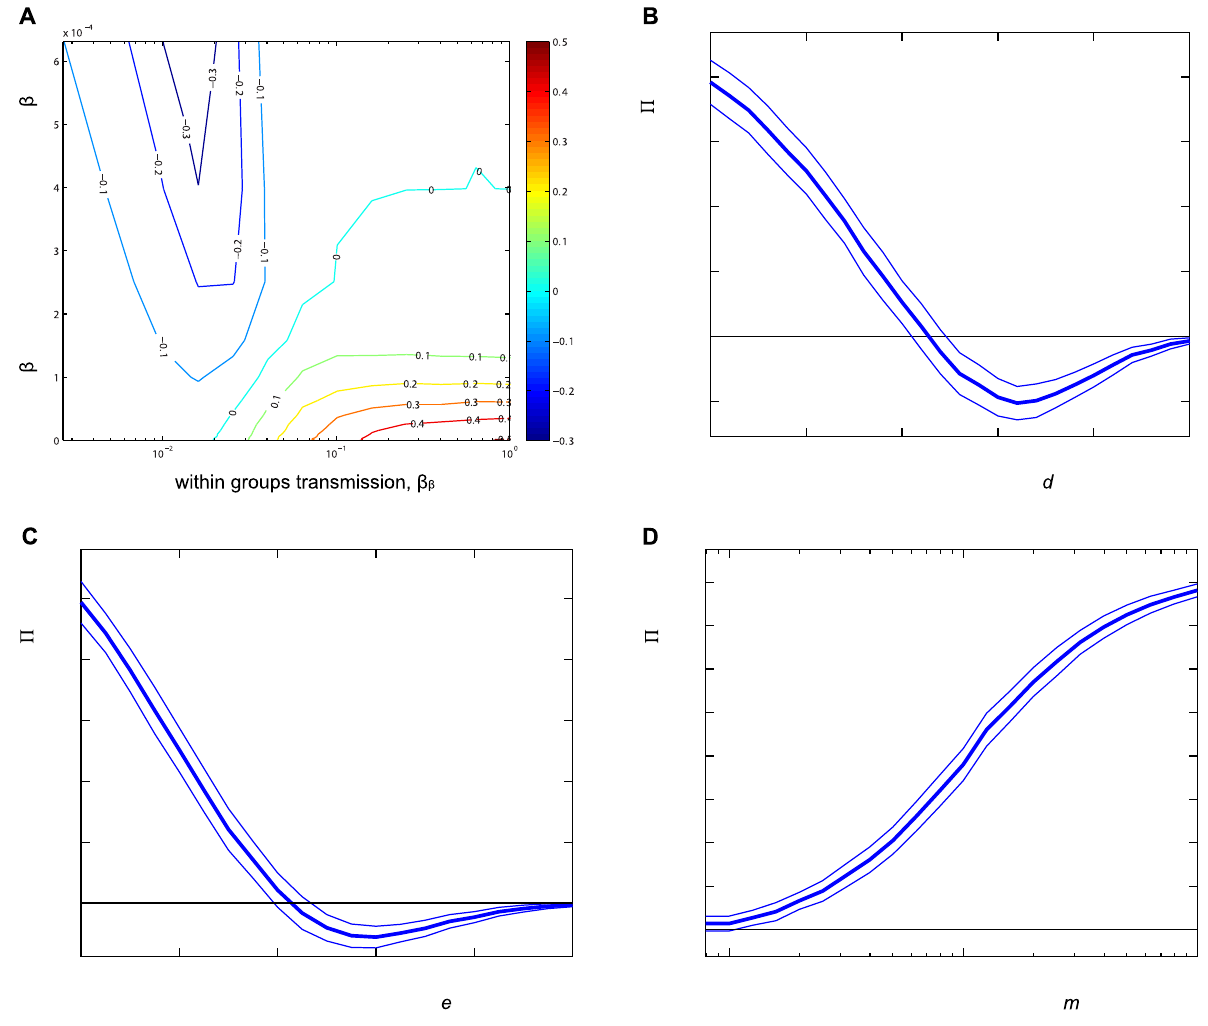
Figure 4. Sensitivity analysis of P in the stochastic model. The size of the perturbation effect, P sites , at time t ~ 20 starting near the disease free equilibrium for (A) Between and within-groups infection rates b b and b w (log scale). (B) Natural mortality rate d . (C) Disease induced mortality rate e . (D) Dispersal rate m (log scale). Default parameters are given in Table 2, and one parameter is varied at a time. This is analogous to Fig. 2 for the non-spatial case. Initial conditions are such that 20% of sites are randomly chosen to start near the endemic equilibrium (with a minimum of 1 infective), while the remainder begin at the disease free equilibrium.